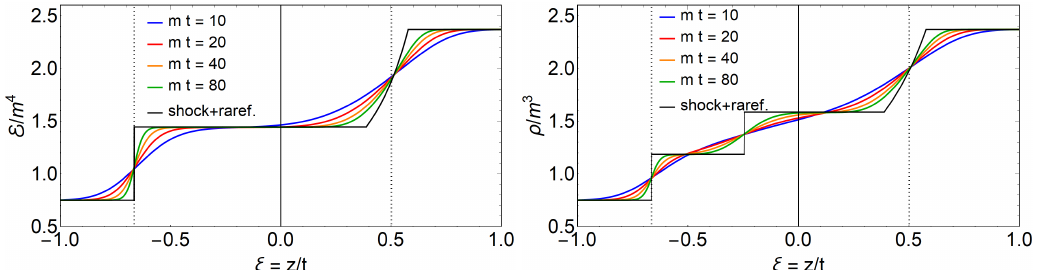
Figure 8: Time evolution of the energy density (left) and charge density (right) as a function of ξ = z / t . At the latest time we managed to obtain ( mt = 80) the solution closely resembles the shock + rarefaction solution found in Section 2.